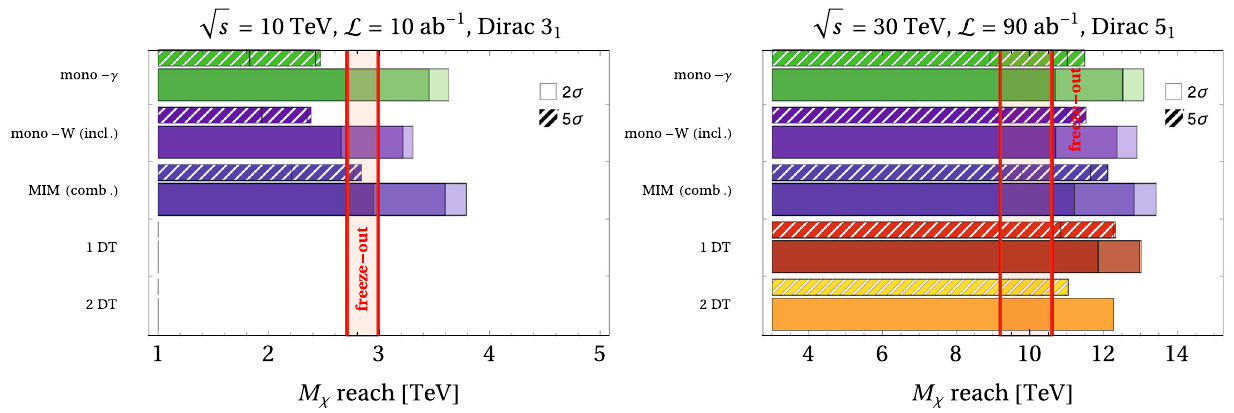
Fig. 9 Different bars show the 2 σ (solid wide) and 5 σ (hatched thin) reach on the fermionic WIMP mass at a muon collider for different search channels. The first three bars show the channels discussed in Sect. 4 where DM would appear as missing invariant mass (MIM) recoiling against one or more SM objects: mono- γ , inclusive mono- W , and the combination of all these MIM channels (blue). The mono- Z channel is not reported since it gives results below the minimum mass shown. The last two bars show the reach of disappearing tracks, requir- ing at least 1 disappearing track (red), or at least 2 tracks (orange). All the results are shown assuming systematic uncertainties to be 0 (light), 1‰(medium), or 1% (dark) for MIM searches, while they are taken 0 (light), 1% (medium), 10% (dark) for the single DT search.